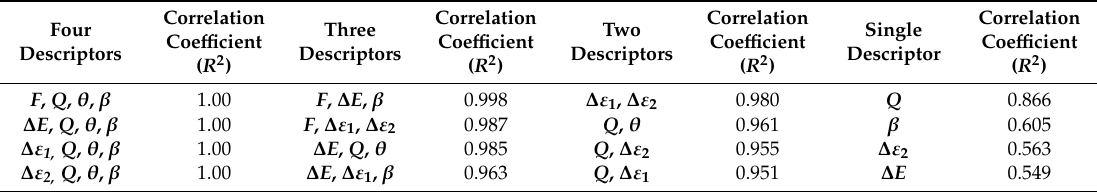
Table 4. Selected values of correlation coe ffi cient ( R 2 ) for Ni1 complexes system by the combinations of four, three, two, and single